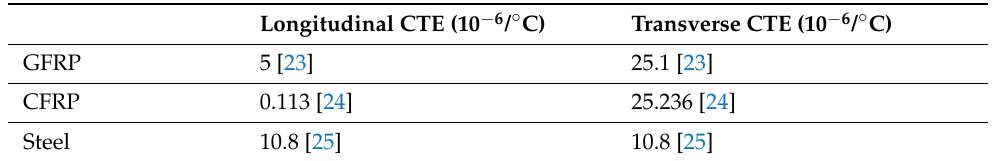
Table 4. Coefficient of thermal expansion (CTE) of CFRP, GFRP and steel forming the individual layers of the hybrid